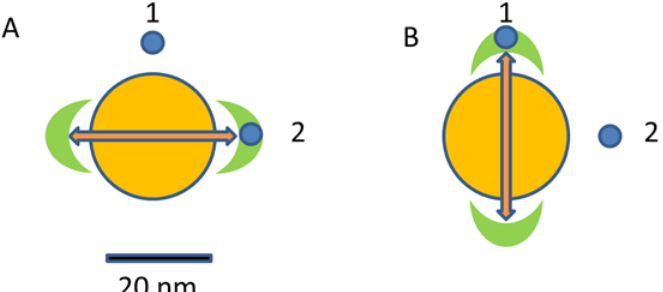
Fig 1. Schematic representation of selection of emission from a specific fluorophore in the proximity of the AuNP. The AuNP is shown schematically in yellow with regions of plasmonic enhancement in green. (A)In part A, the direction of linear polarization of the laser light is horizontal: particle 1 is not in the region of enhancement but particle 2 is. Therefore most of the fluorescence will arise from particle 2. (B)If the polarization of the laser beam is vertical, only the fluorescence from particle 1 will be